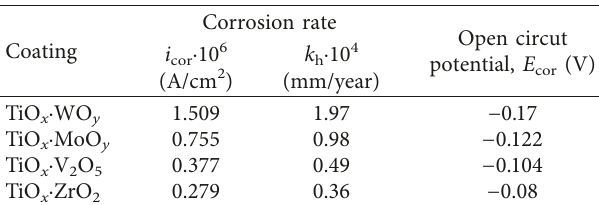
x · WO y ; 2: TiO x · MoO y ; 3: TiO x · V 2 O 5 ; 4: TiO x · ZrO 2 and the corresponding Table 4: Corrosion parameters of samples with coatings: TiO oxides of metals in solution 0.1 M NaCl.